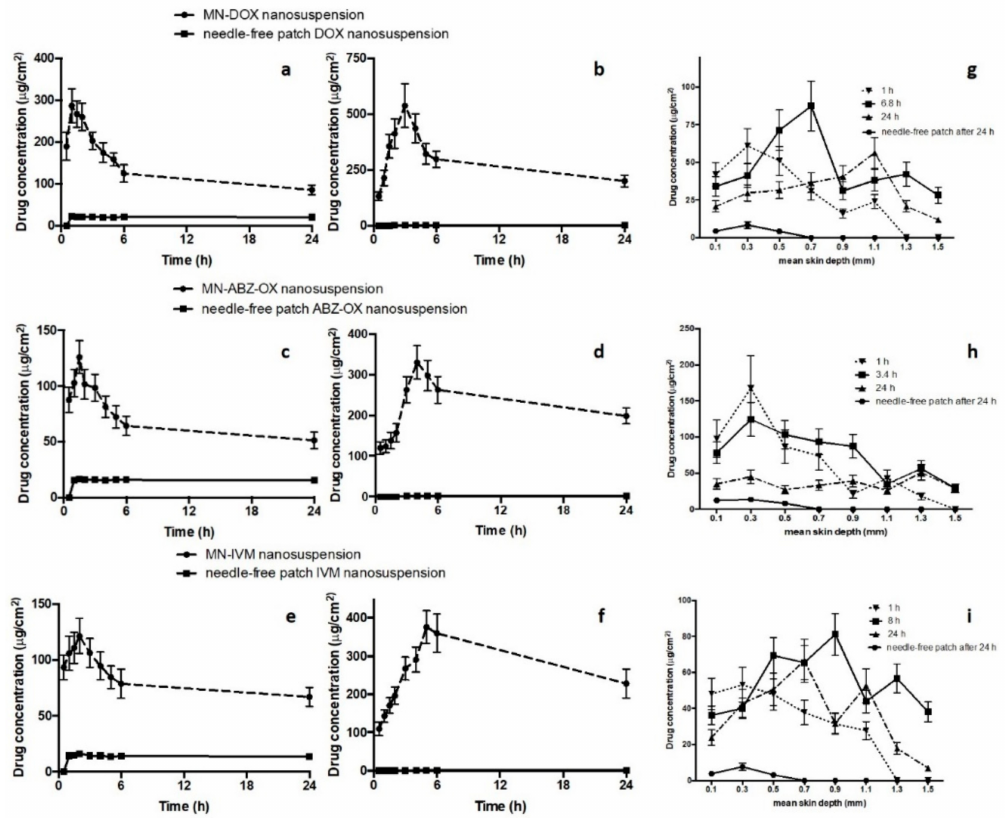
Figure 7. The drug concentration and time profile of DOX in epidermis ( a ) and dermis ( b ), DEC in epidermis ( c ) and dermis ( d ), and ABZ-OX in epidermis ( e ) and dermis ( f ) layers of excised full-thickness neonatal porcine skin, following the application of MN, in comparison with the application of free-needle patches (means ± S.D., n = 3). The concentrations of drugs in a di ff erent layer of neonatal porcine skin, following the application of MN containing ( g ) DOX NS; ( h ) ABZ-OX NS, and ( i ) IVM NS, in comparison with the free-needle patch (means ± S.D., n =